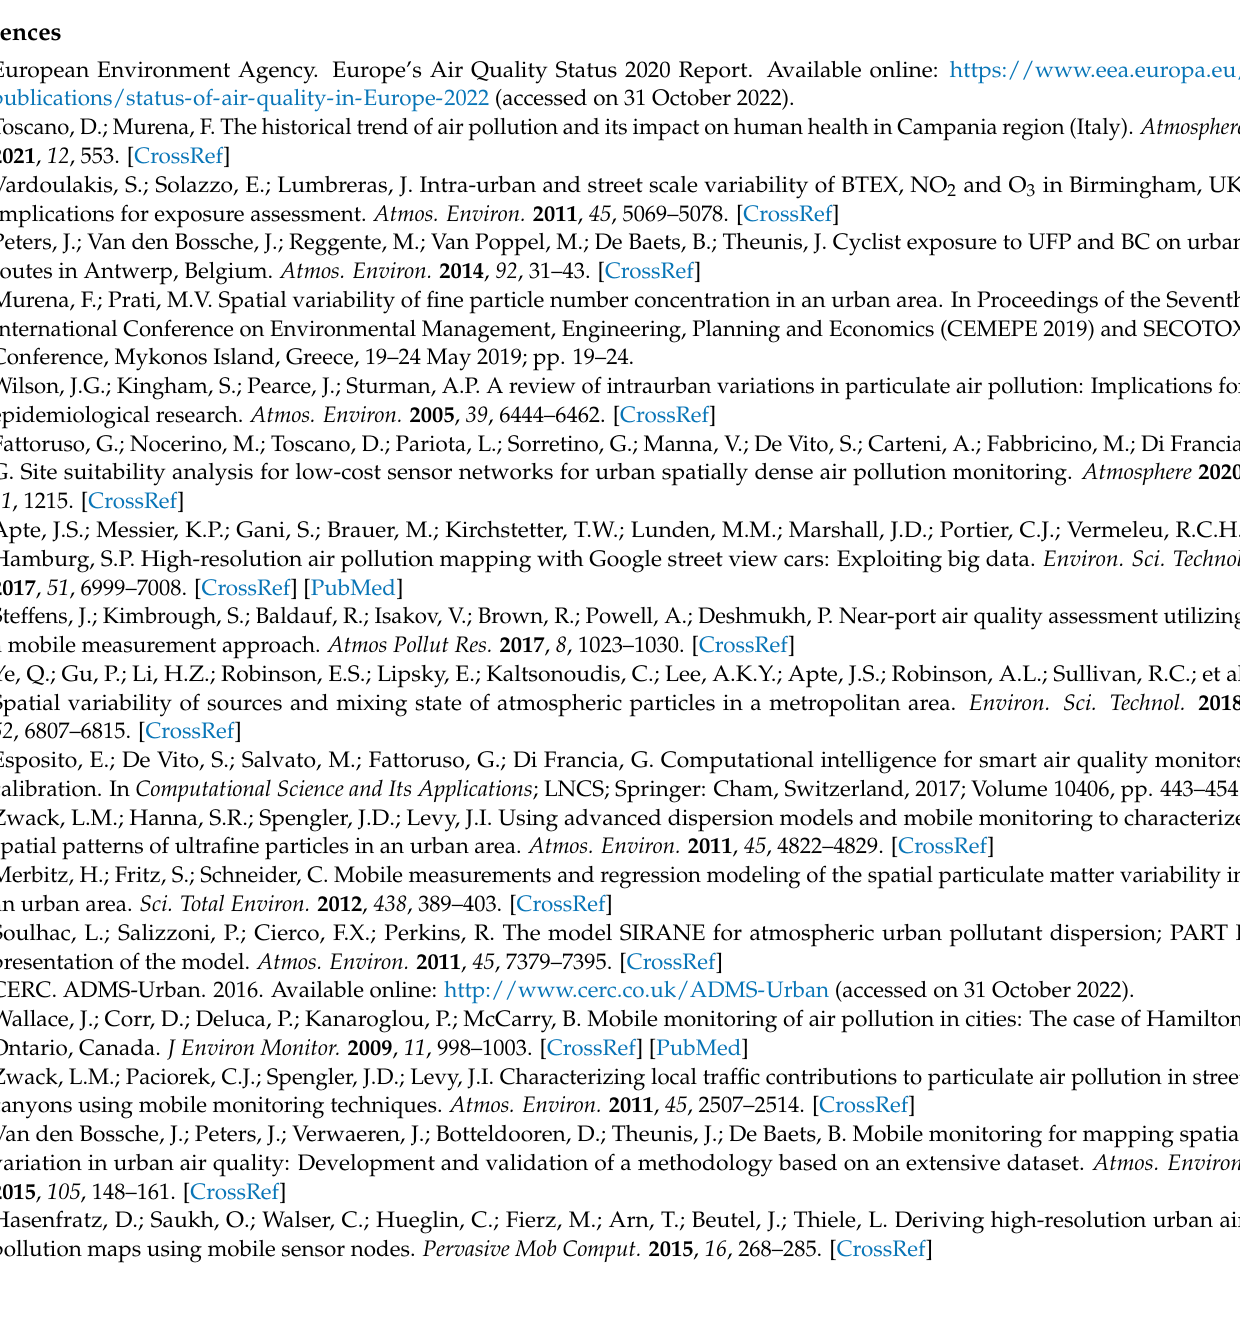
Figure A6. Maps of the estimated concentrations on 21 June at 5 p.m.: ( a ) CO concentrations; ( b ) NO 2 concentrations.